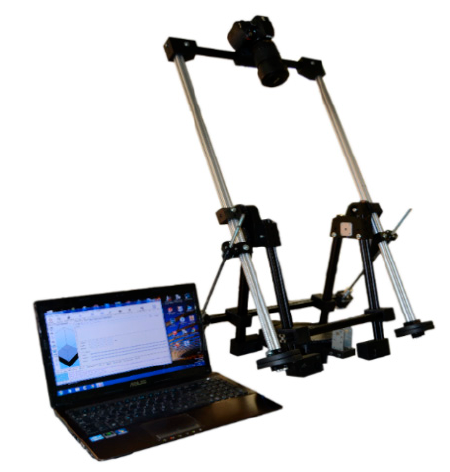
Figure 9. Prototype with camera mounted (Source: self-made).